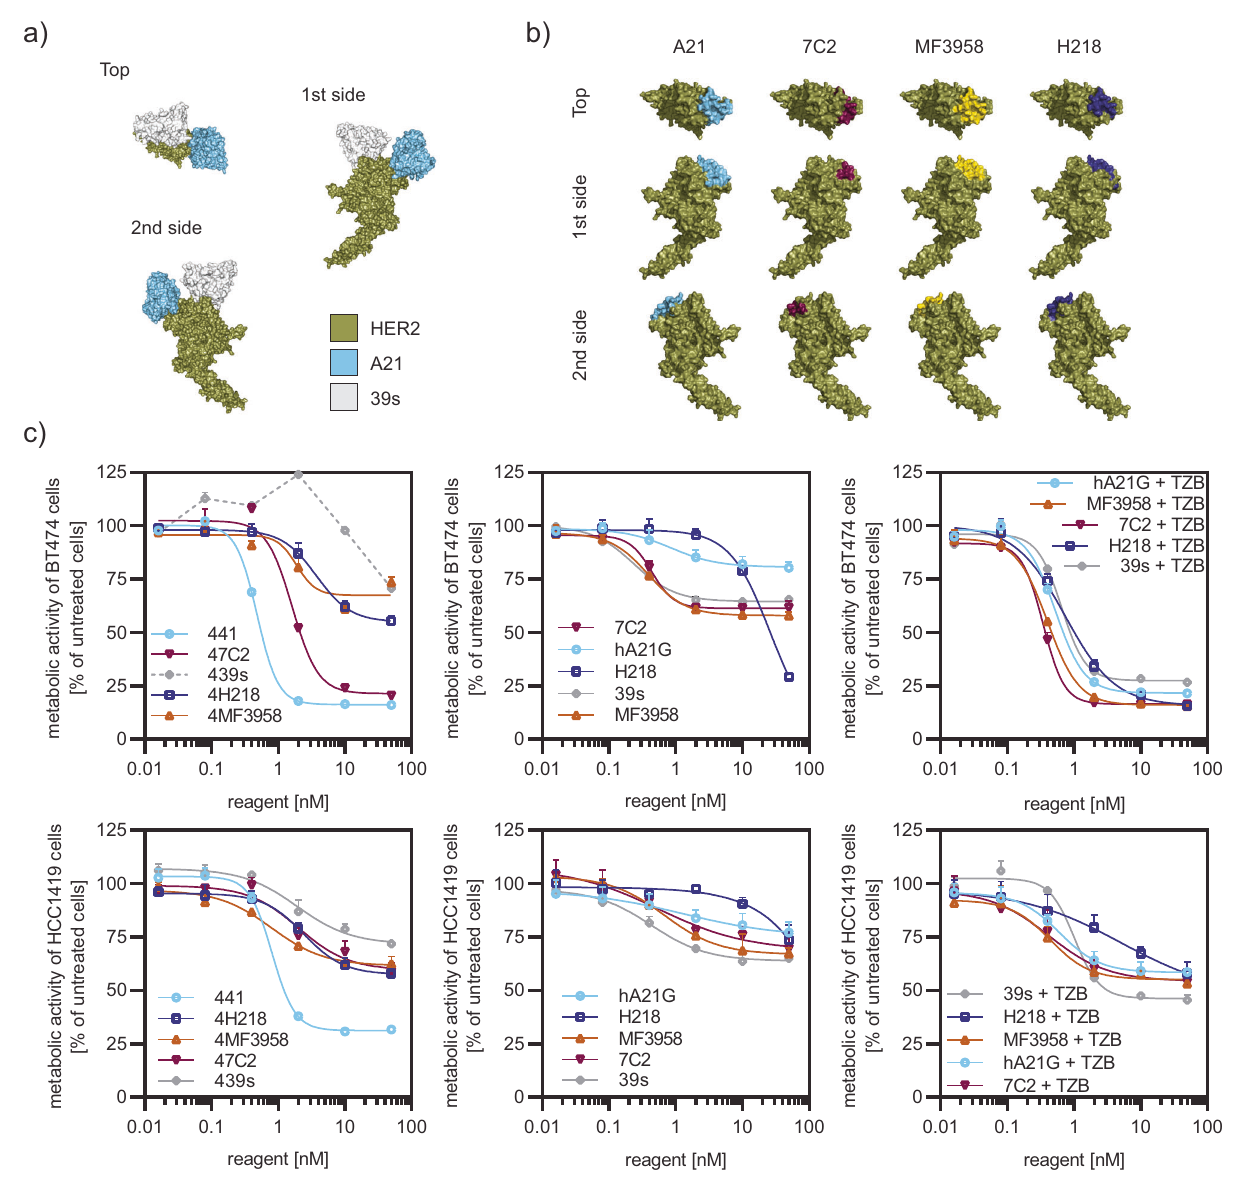
Fig. 3 Epitope on domain I of HER2 determines activity of fusion construct. a Binders recognizing different epitopes on HER2 were tested as fusion partners in our format. Antibody 39s and A21 (shown as Fv fragments) recognize epitopes on top of HER2, but A21 is binding to D1 while 39s is binding to D2. b Crystal structures of three further antibodies complexed with HER2 (7C2, MF3958, and H2-18) were previously shown to partly overlap with the A21 epitope, but they bury less surface area upon binding (epitopes are colored). Structures were derived from PDB fi les 3H3B, 6ATT, 5O4G, and 3L3W and the 7C2 epitope 30 . c Replacement of A21 in our scFv – IgG fusion protein by any binder in ( b ) led to a reduction in antiproliferative activity of the resulting fusions ( n = 3 biological replicates, mean plus error bar SD), tested in BT474 and HCC1419 cells. The fusions with the TZB scFv are named by “ 4 ” followed by the A21 replacement name (left panels). Note that, in the case of 39s, the fusion even augmented the proliferation of BT474 cells. Single mAbs (middle panels) were only modestly active ( n = 3, error bar SD). Equimolar combination treatments of the mAbs with TZB (right panels) were all indistinguishable ( n = 3, error bar SD) from each other. 441 proved superior, especially in the TZB-insensitive cell line HCC1419 (lower row). Source data are available in the Source Data fi